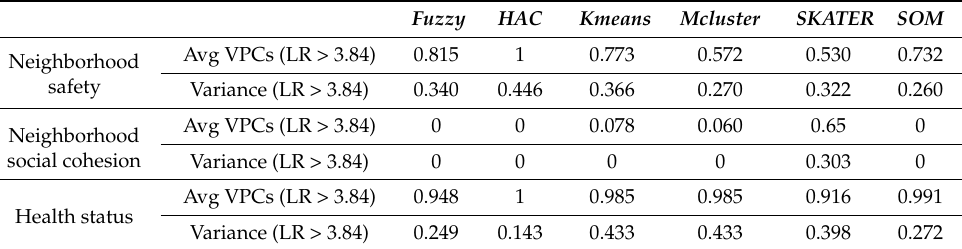
Table 1. The average variance partition coefficients (VPCs) of the multilevel models in relation to the citizens’ perceptions and the neighborhood PSI context based on six clustering algorithms. ( Fuzzy = Fuzzy clustering, HAC = Hierarchical clustering, Kmeans = K-means clustering, Mcluster = Gaussian Mixture Modelling for Model-Based Clustering, SKATER = Spatial “K”luster Analysis by Tree Edge Removal, SOM = Self-organization